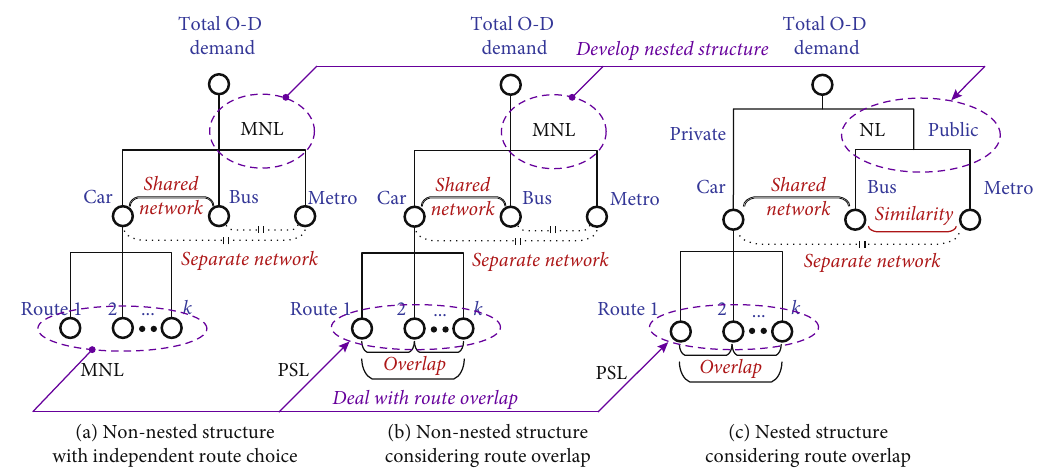
Figure 3: Structures for nonnested and nested multimodal models.